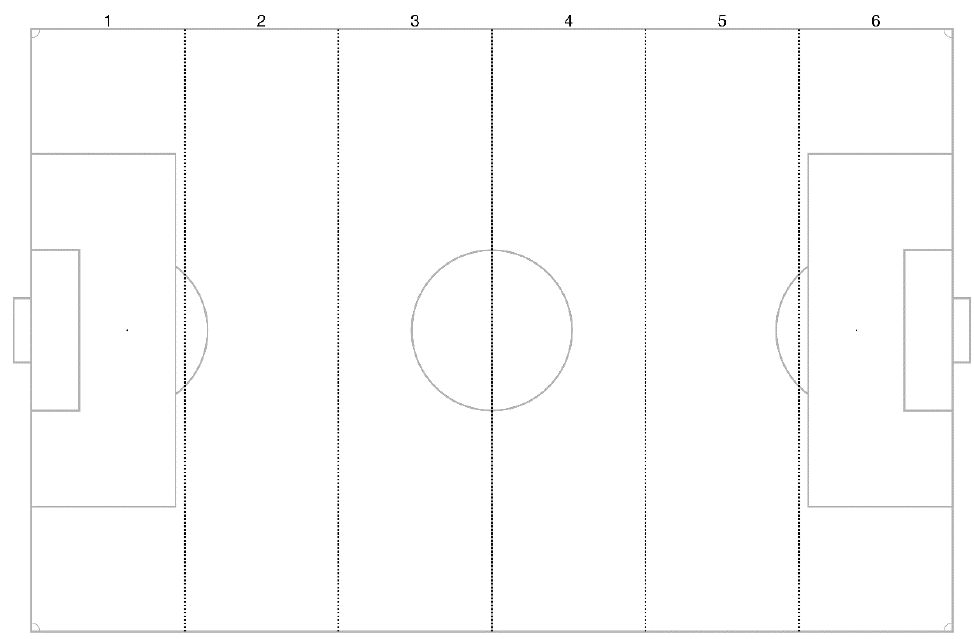
Figure 1. The field was divided into different six